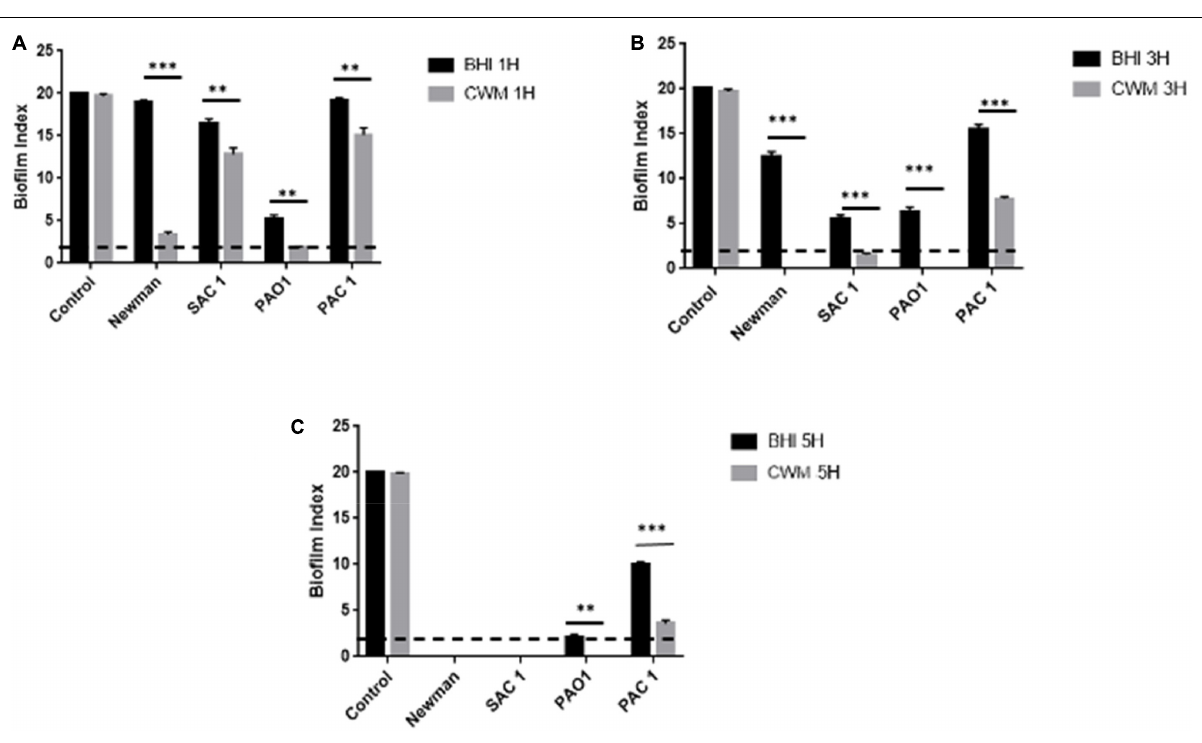
FIGURE 3 | Kinetics of biofilm formation assessed by BioFilm Ring Test R (cid:13) at 1 h (A) , 3 h (B) , and 5 h (C) for clinical and reference S. aureus and P. aeruginosa strains. Comparisons were performed with t -test. Error bars represent standard deviation. Significance was set to a p < 5%. The dotted horizontal line < 2 represents the cutoff for fixed biofilm. Control is well without bacteria. ∗∗ p < 0.01; ∗∗∗ p <